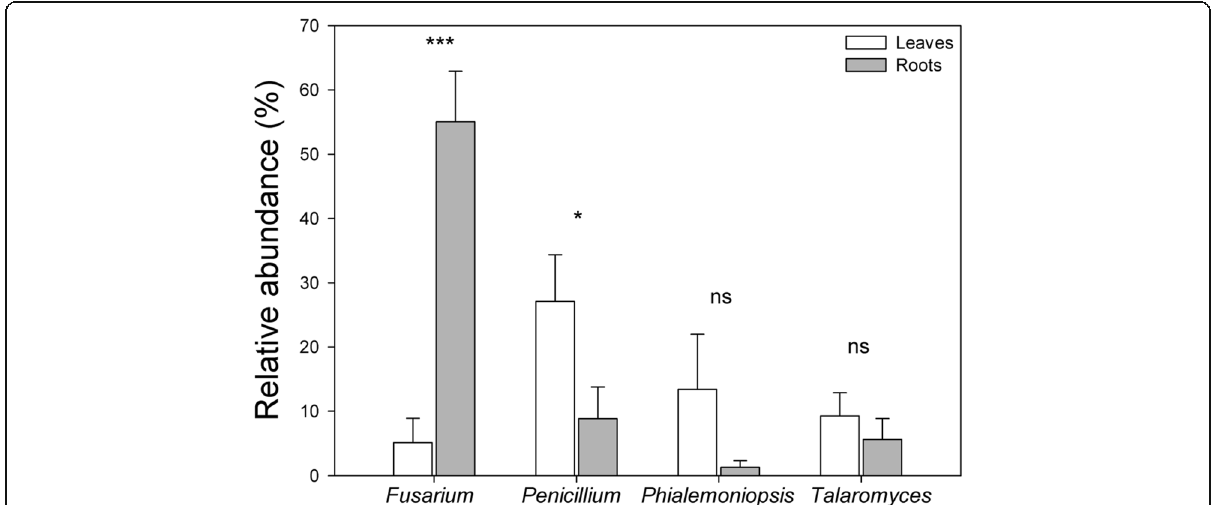
Fig. 2 Relative abundance (average + SE, N = 10 individuals) of the four most abundant fungal endophyte genera found in A. chilensis leaves (gray bars) and roots (black bars). Asterisks indicate significance level (Nested ANOVA): * P < 0.05, ** P < 0.01, *** P < 0.001, ns indicates non-significant differences